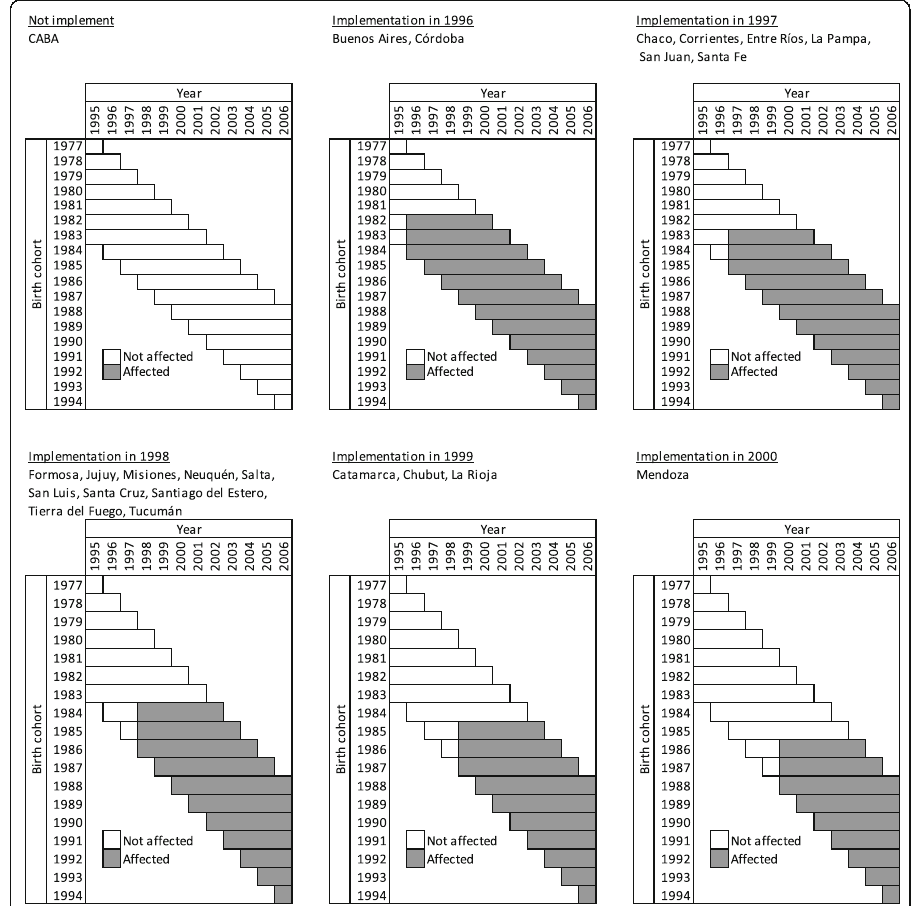
Fig. 7 Birth-cohorts affected by the reform. Note: CABA City of Buenos Aires (Federal District). Source: Crosta (2007), own